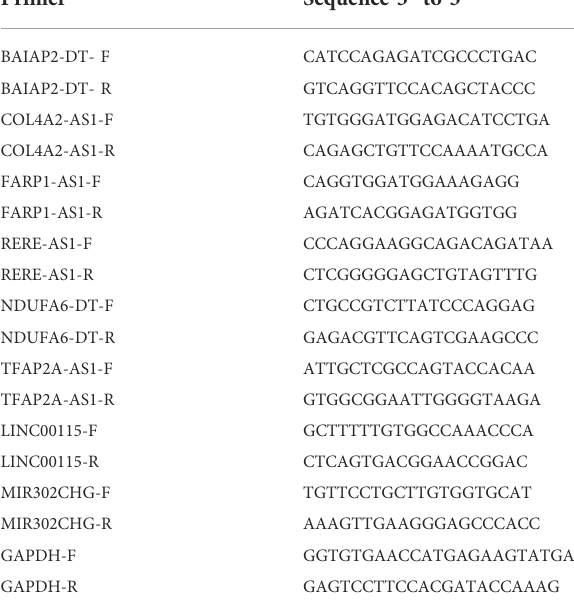
TABLE 2 Primer sequences used for